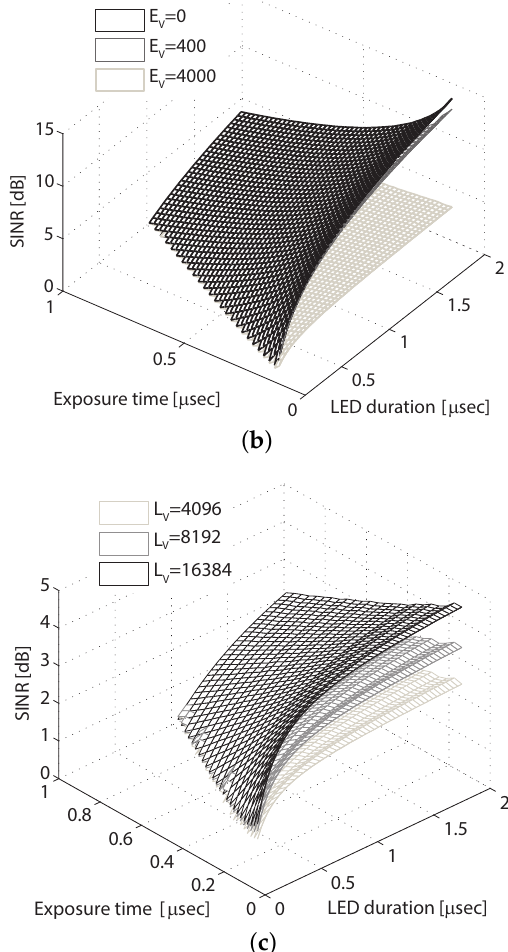
Figure 11. Effect of system parameters on the signal to interference plus noise ratio (SINR). ( a ) SINR ≤ t ≤ 1 with E v = 0, L v = 8192, t f = 1 , 1 , 500 ≤ f led ≤ 8000; ( b ) SINR with L v = 8192, 8000 100 1000 ≤ t ≤ 1 t f = 1 , 1 , 500 ≤ f led ≤ 8000; ( c ) SINR with E v = 40,000, t f = 1 8000 100 1000 500 ≤ f led ≤